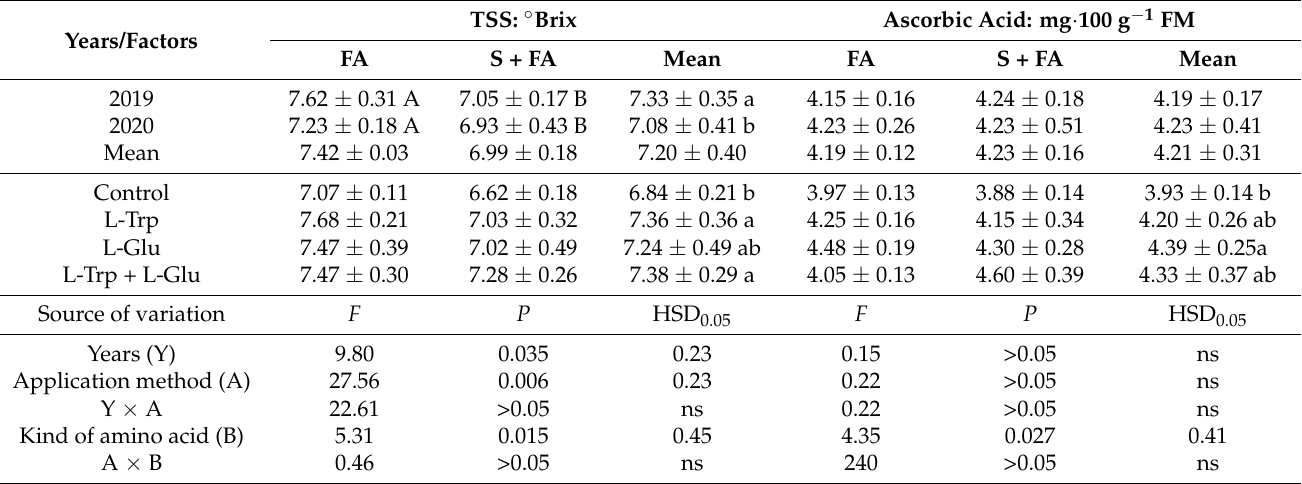
Table 8. The effect of L-tryptophan and L-glutamic acid, methods of their application, years on the content of total soluble solid (TSS), and ascorbic acid in carrot storage